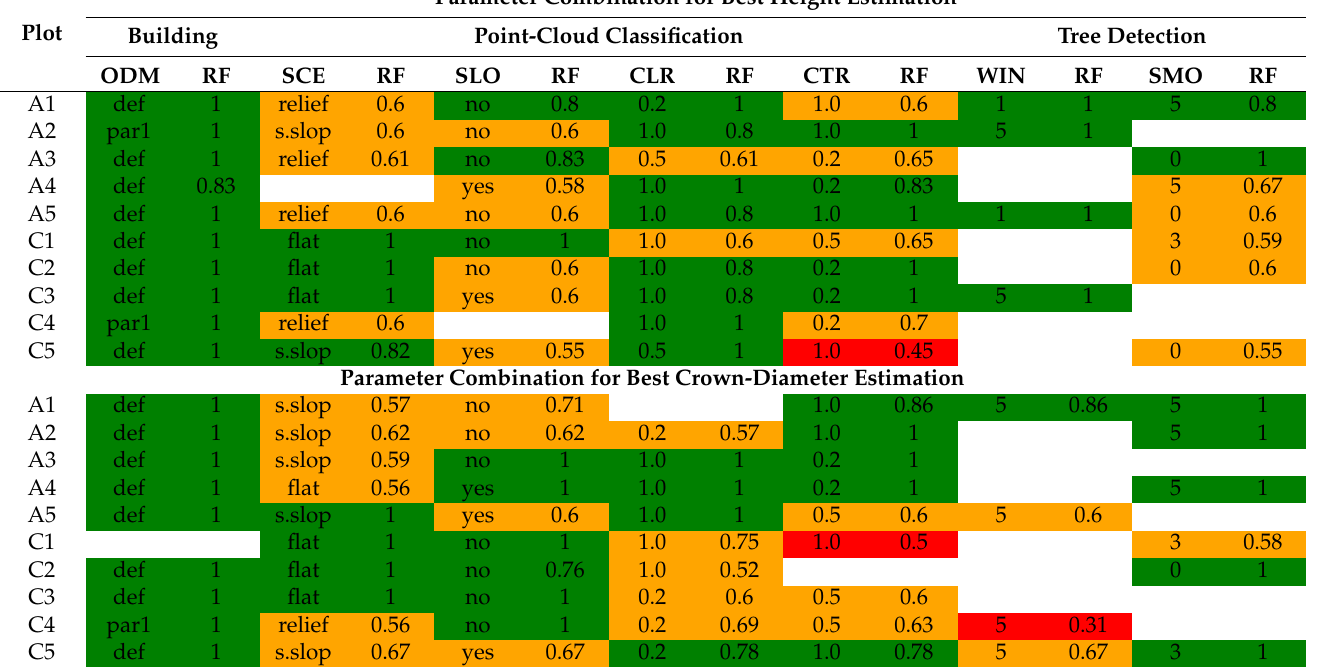
Table 3. Relative frequency of parameter-combination levels for tree height, crown diameter, and crown